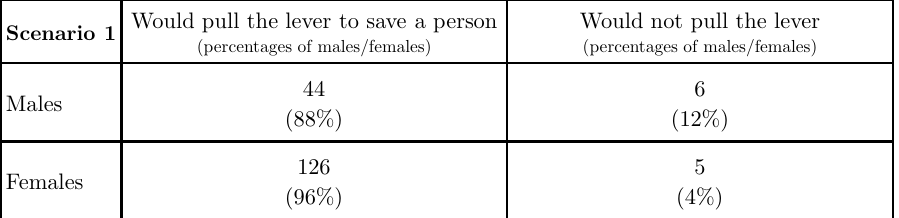
Results of Ill-informed Bystander , Bystander at the Switch , and Fat Man scenarios for males and females Would pull the lever to save a